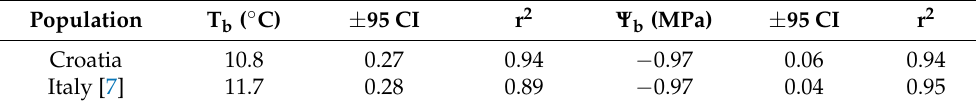
Table 4. Comparison of base temperature (T b ) and base water potential ( Ψ b ) of Echinochloa crus-galli Croatian and Italian population estimated with the bootstrap method [28], 95% confidence interval (95% CI), and coefficient of determination (r 2 ). Estimated values of the Italian population were taken from Masin et al. [7].